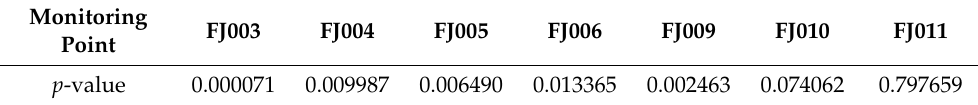
Table 5. Results of the ADF test for time-series displacement data at 7 monitoring